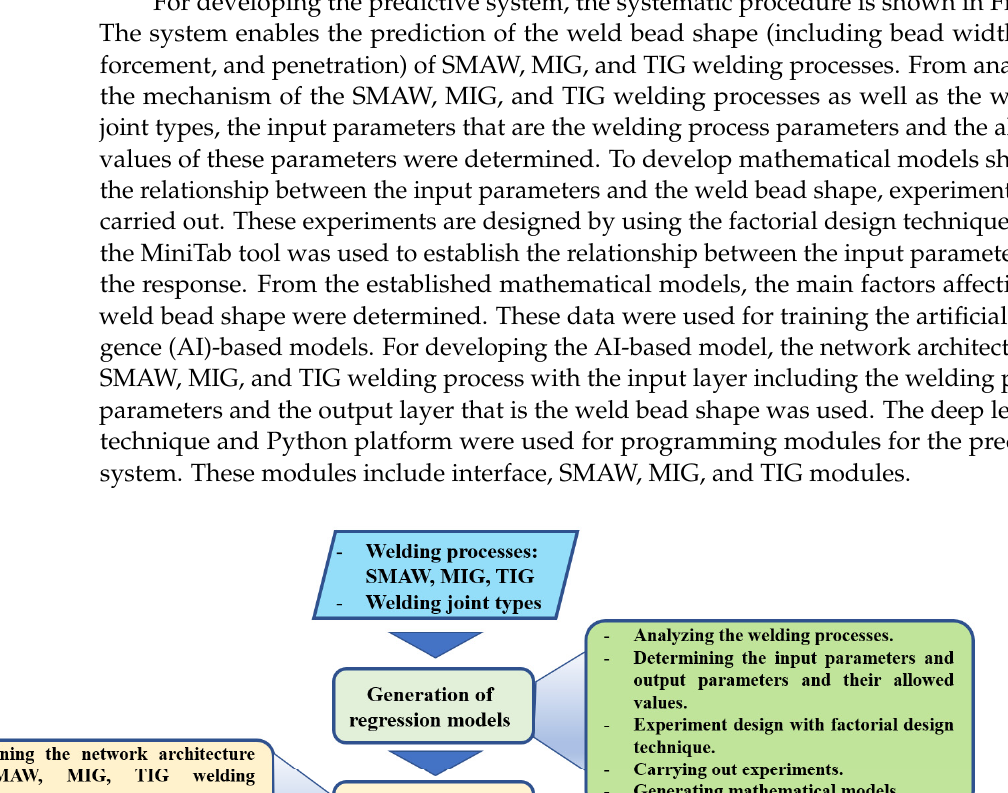
Figure 2. Mechanism of SMAW welding process. Figure 3 shows the mechanism of the tungsten inert gas (TIG) welding process. The TIG process uses a power source, a shielding gas, and a tungsten inert gas torch. The TIG welding process is used to produce weld joints with a non-consumable tungsten electrode. In some cases, the fi ller rod is used to have the added material to fi ll up the gap between two joints. In the TIG welding process, the arc is formed between a pointed tungsten